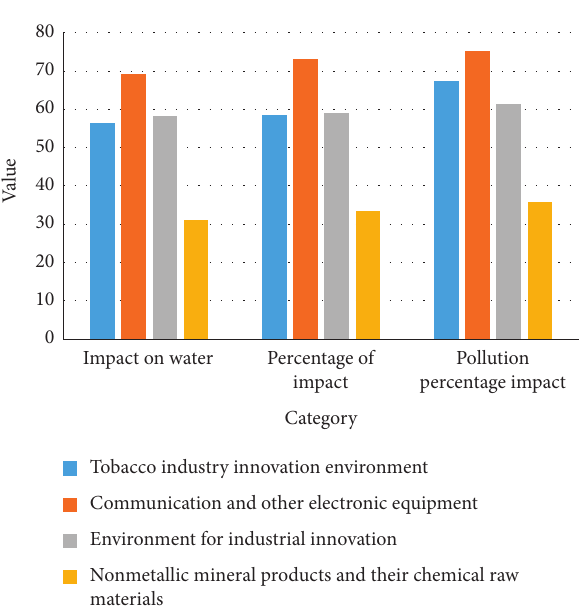
Figure 3: Code and its weight of every part.